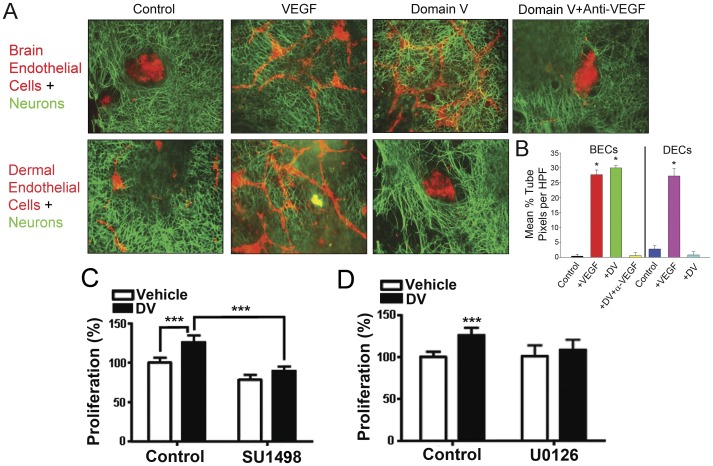
DV enhances brain endothelial cell capillary tube-like structure formation in neuronal co-culture in a VEGF-dependent fashion.(A) BECs or mouse dermal endothelial cells (DECs, red) were cultured on a bed of rat cerebellar granule neurons (green) in serum free medium for 6 hours +/− PBS vehicle control, VEGF, DV, or DV+VEGF neutralizing antibody. Scale bar is 50 µm. (B) Quantification of capillary tube-like structures as in A. *P<0.05 compared to corresponding control. (C) and (D) Quantification of percent BEC proliferation after 24 h (in reference to control, PBS vehicle treated condition arbitrarily set at 100%) treated as labeled. ***P<0.001.